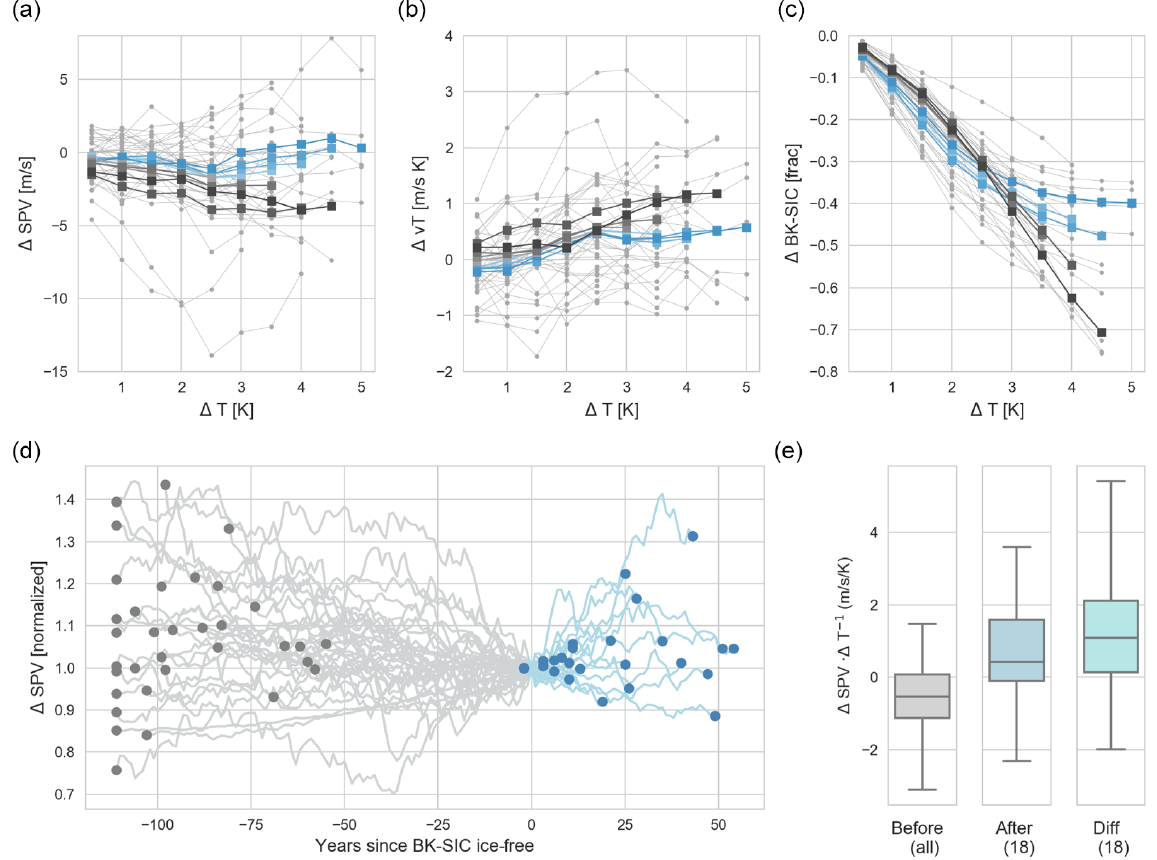
Figure 2. The role of the timing of the BK seas becoming ice-free. (a–c) As in Fig. 1a–c but with the ensemble mean indicated separately for the subsets of models where the BK seas become ice-free early (before 2090, blue lines) and those which are ice-free late (after 2090, dark grey lines). (d) Time series of moving 30-year mean SPV normalized by the 30-year mean reached before the BK seas become ice-free (in OND). Grey lines thus show the evolution of change when there is sea ice and blue lines for when BK is ice-free. Dots indicate the values at the end (blue) and at the start (grey). (e) Boxplot of SPV change before and after BK is ice-free (normalized by global mean warming level over the respective period), as well as the difference for each model. The boxes indicate the inter-quartile range, and the whiskers represent the upper and lower quartile ranges. Only models which were ice-free for at least 10 years (i.e. before 2090) are included in the latter two boxplots (in total 18 models). In all panels, changes were calculated relative to the 1960–1989 reference period (see also Sect.